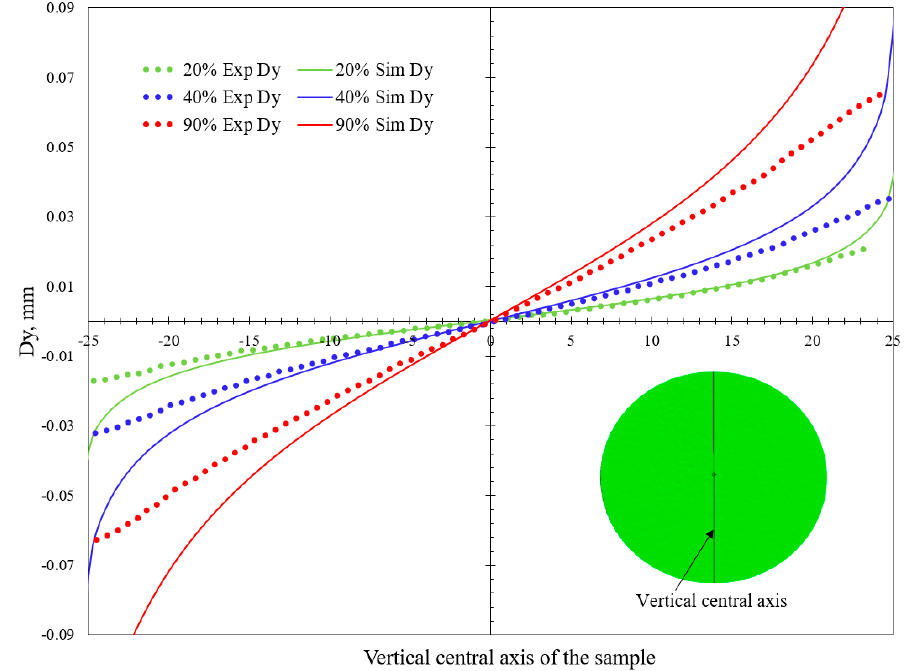
Figure 12. Changes in vertical displacement ( Dy ) along the centerline: DIC vs. simulation results.